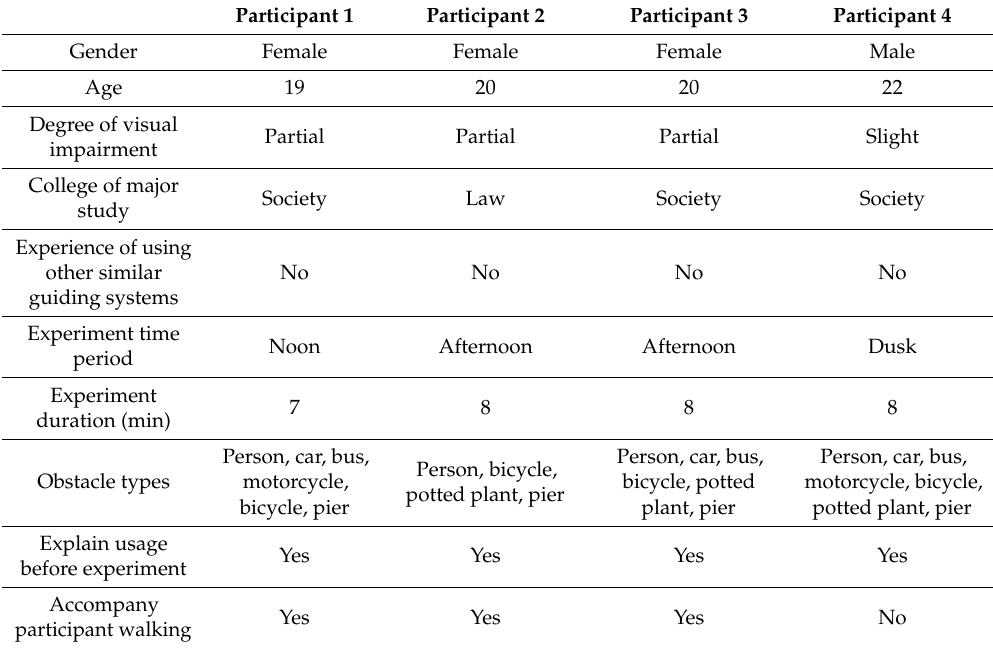
Table 1. Personal and experimental details of each